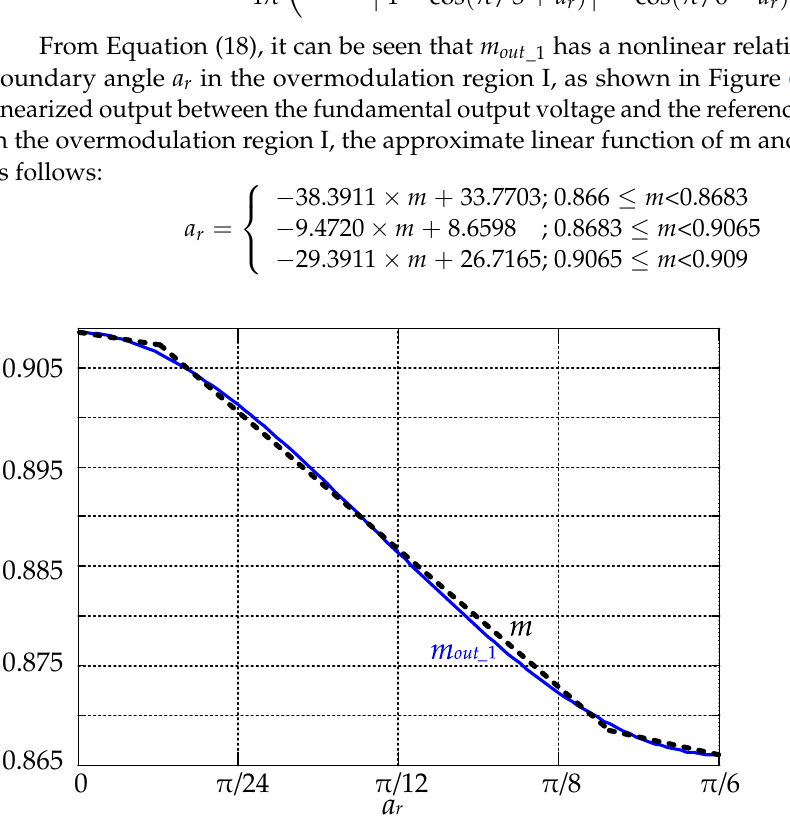
modulation region II, as shown in Figure 7.